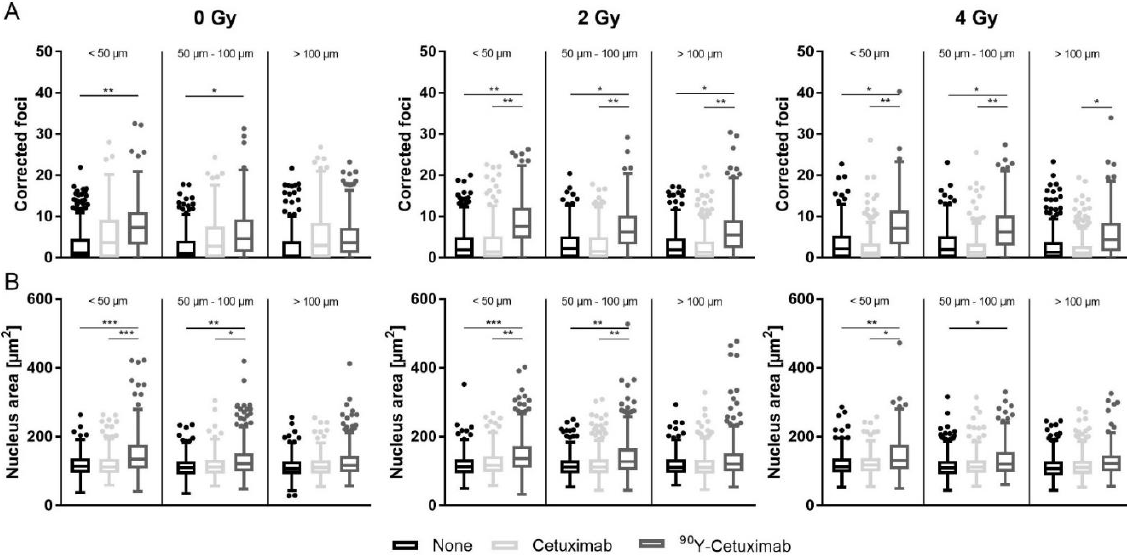
Figure 2. Analysis of DNA damage and cell nucleus area determined by γH2AX foci assay upon monotherapy or combination therapy. Corrected foci (cfoci) and nucleus area of FaDu DD xenograft tumors treated with monotherapy or combination therapy of external tumor irradiation (0, 2, or 4 Gy) plus Cetuximab or 90 Y-Cetuximab. FFPE tumors were stained for γH2AX and counterstained with DAPI. The range for γH2AX foci enumeration was classified into three categories based on the distance from the nearest perfused vessel (<50 µm, 50–100 µm, and >100 µm). Five analyzable nulcei per distance category were randomly selected for manual assessment of γH2AX foci counts ( A ) and nucleus size measurement ( B ). cfoci were calculated and a linear mixed-effects model was performed on square root transformed cfoci and log transformed nucleus area. (*: p < 0.05, **: p < 0.01, ***: p < 0.001).